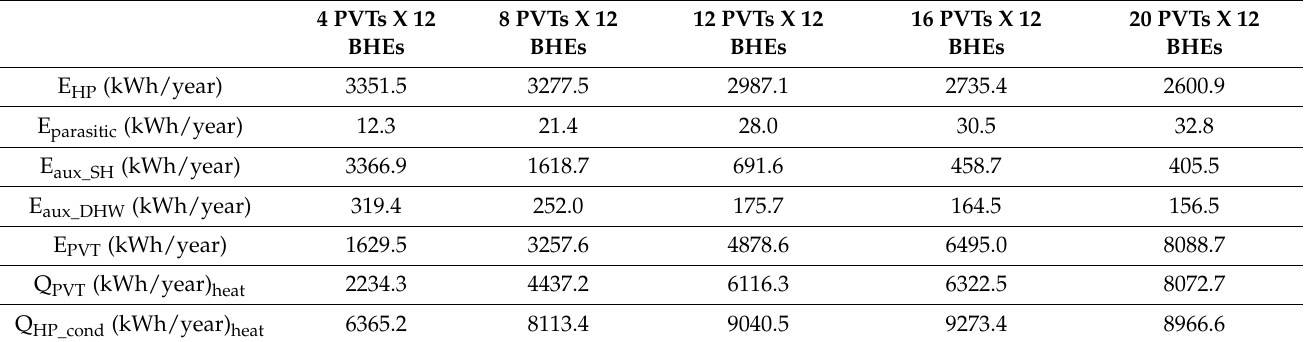
Table 6. Annual electric energy (E) consumed on the SAGSHP system and the annual electricity and heat produced by the PVTs, along with the heat provided by the heat pump for Melbourne.